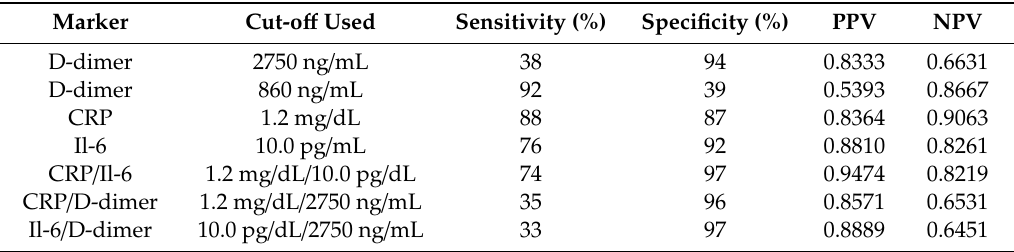
Table 2. Results for D-dimer, CRP, IL-6, and their combinations in diagnosing prosthetic joint infection (PJI).